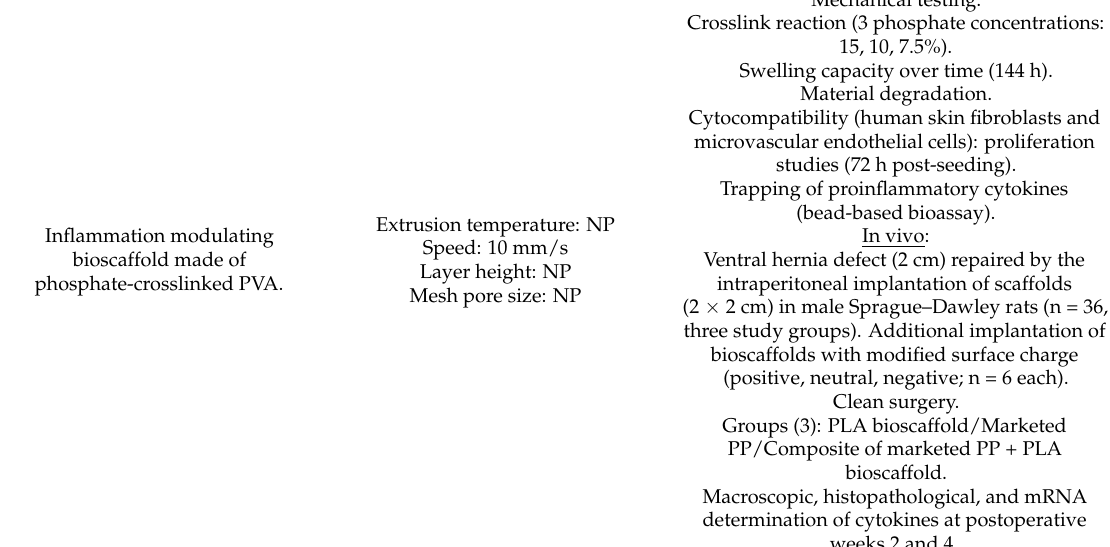
Composite scaffolds made of printed PCL meshes and electrospun type-I collagen